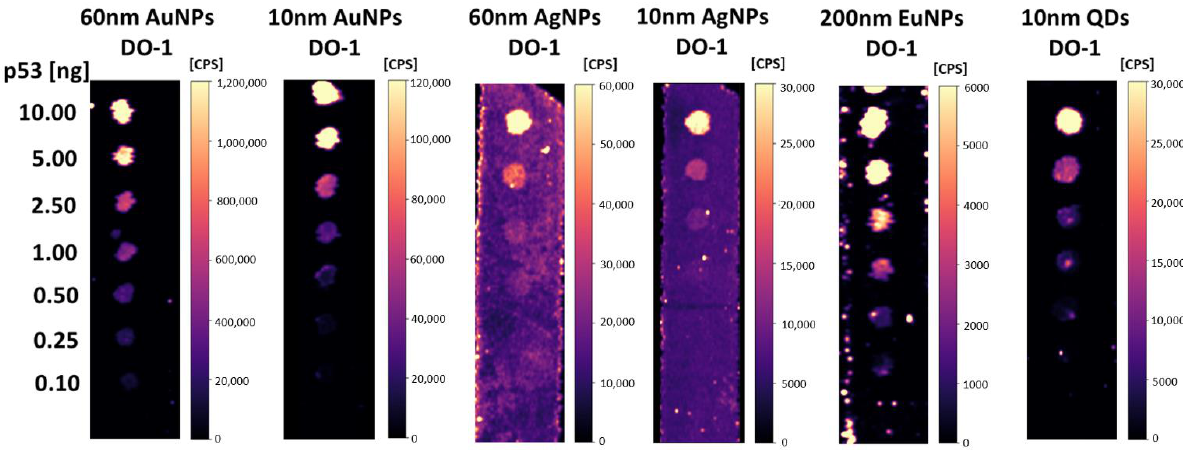
Figure 3. LA-ICP-MS dot-blot analysis of p53 protein standard (total protein amount 0.10–10.00 ng) using DO-1 antibody conjugates with Au, Ag, Eu, and QD nanoparticles.